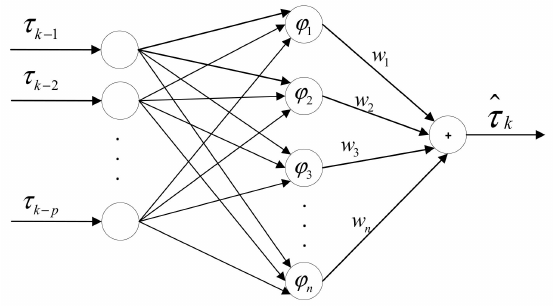
Figure 3. RBF neural network delay prediction